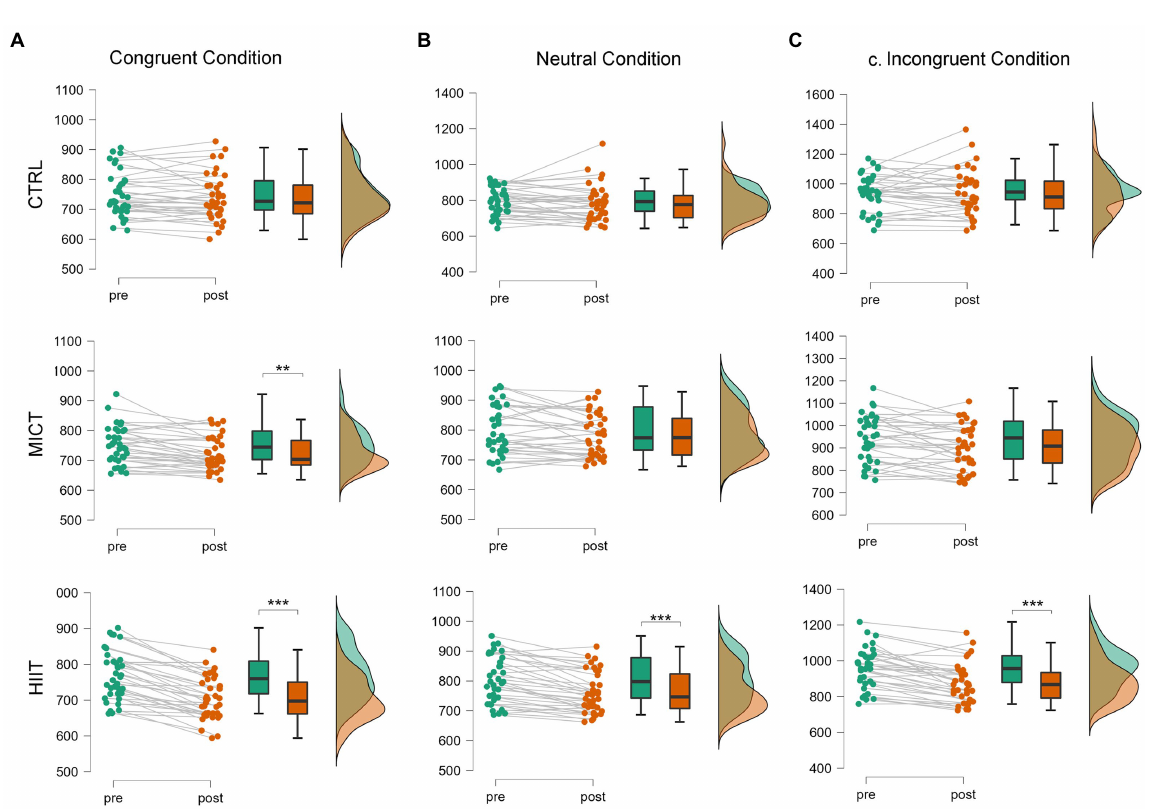
FIGURE 1 Raincloud plots for time in ms on the three conditions of the Stroop Reaction Time ANOVA RM. Significant effect of time * p < 0.05, ** p < 0.01, *** p < 0.001. (A) Congruent Condition of the Stroop Test. (B) Neutral Condition of the Stroop Test. (C) Incongruent Condition of the Stroop